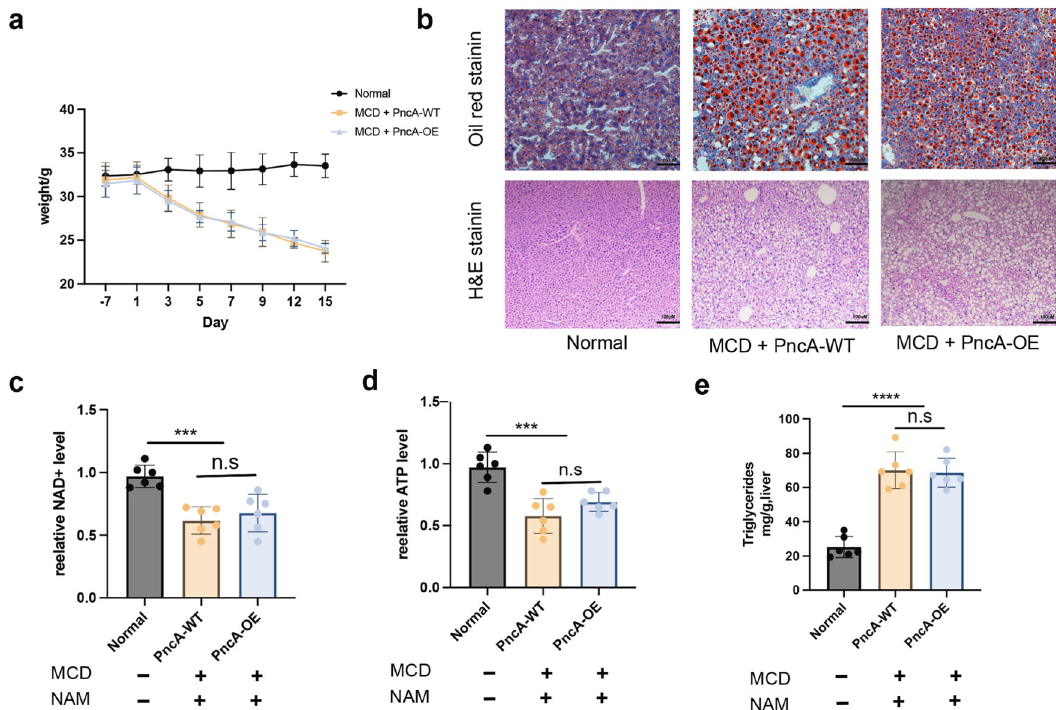
Fig. 4 PncA-overexpressing E. coli did not signi fi cantly ameliorate mouse NAFLD. a Body weight of MCD-induced NAFLD model mice ( n = 6). b Representative Oil Red O staining (top) and hematoxylin and eosin (H&E) staining (bottom) of mouse liver sections. c Liver NAD + level in NAFLD model mice treated with different bacteria. d Relative content of ATP in mouse liver. e Content of triglyceride in mouse liver. ( n = 6, *** p < 0.001, **** p < 0.0001, n.s = no signi fi cance). Scale bars 100 µ m.